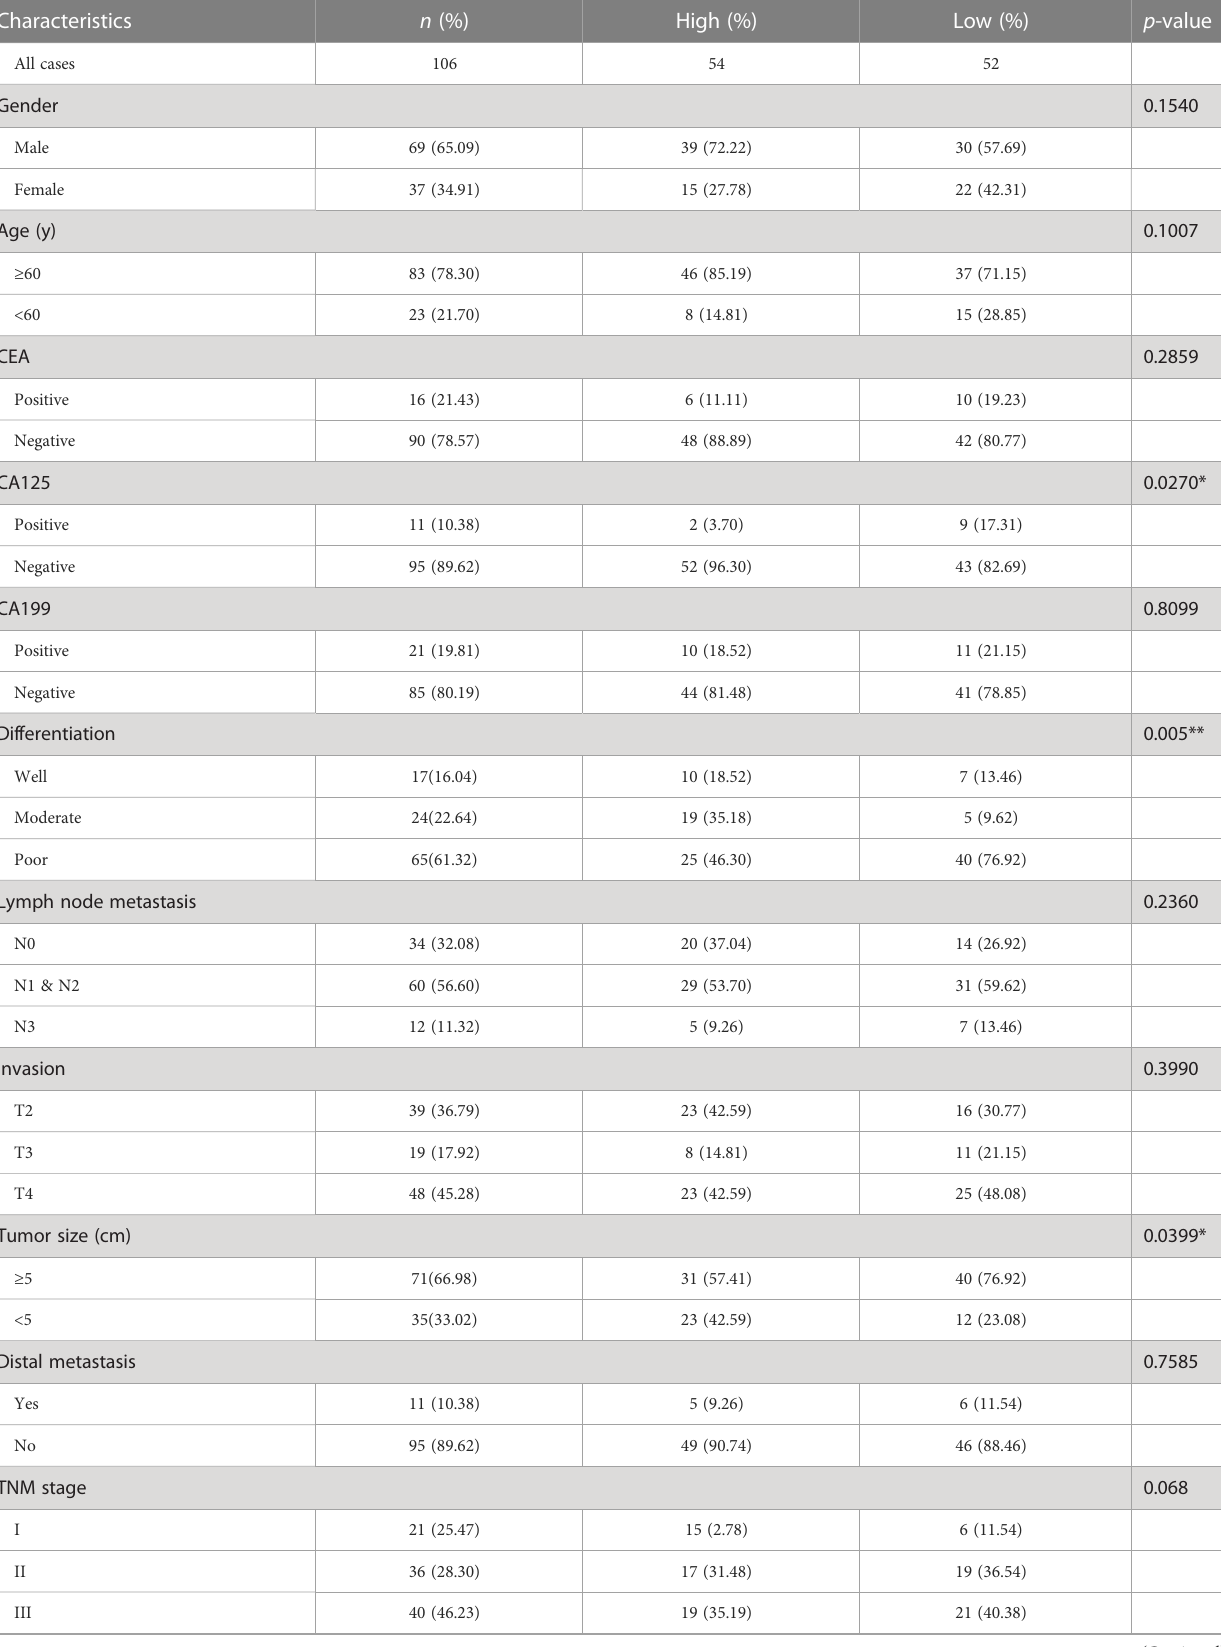
TABLE 1 The correlation between the amount of tRF-33-P4R8YP9LON4VDP in plasma and clinicopathological features of gastric cancer patients.